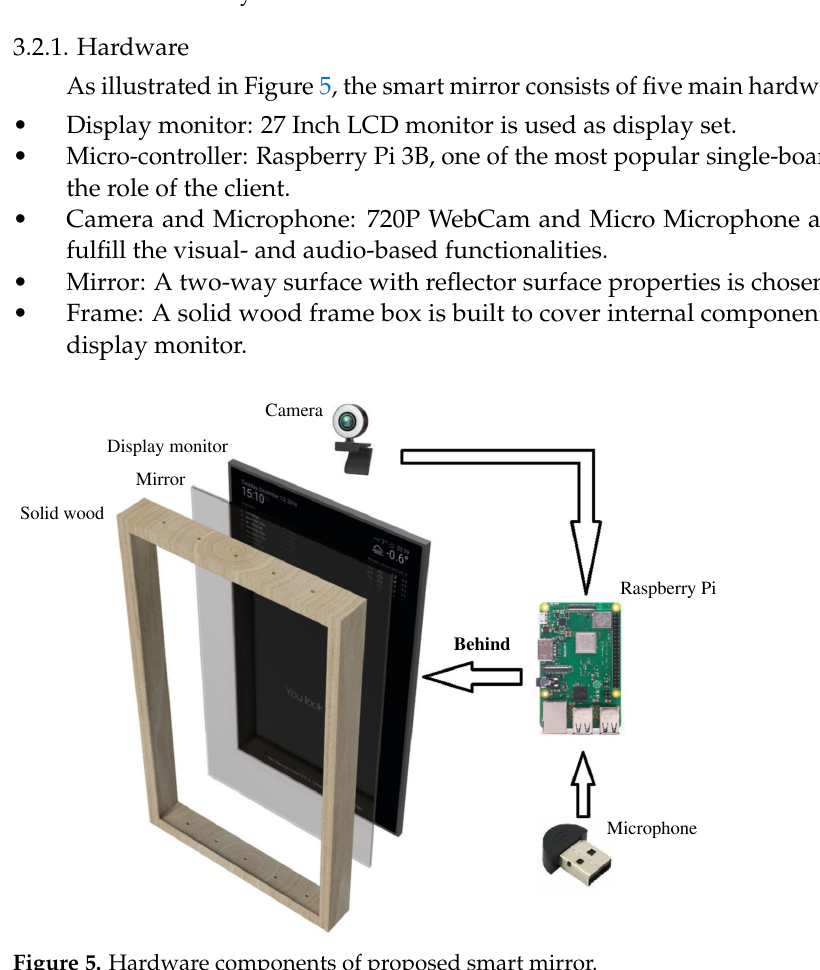
Figure 5. Hardware components of proposed smart